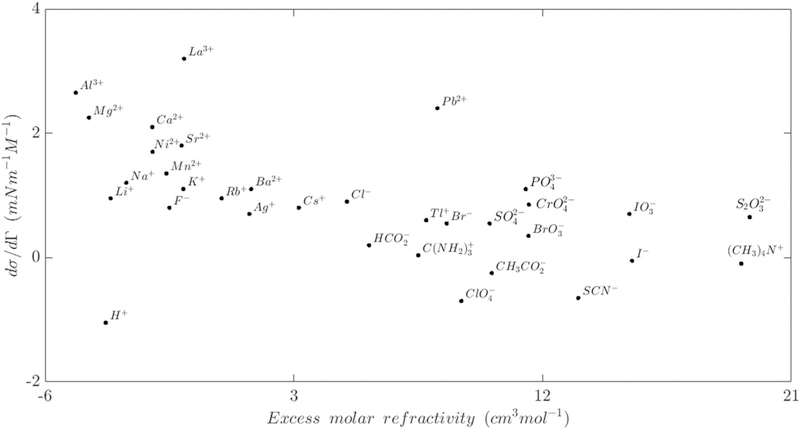
Ionic surface tension increments of aqueous ions at ambient conditions as a function of the excess molar refractivity.98,99